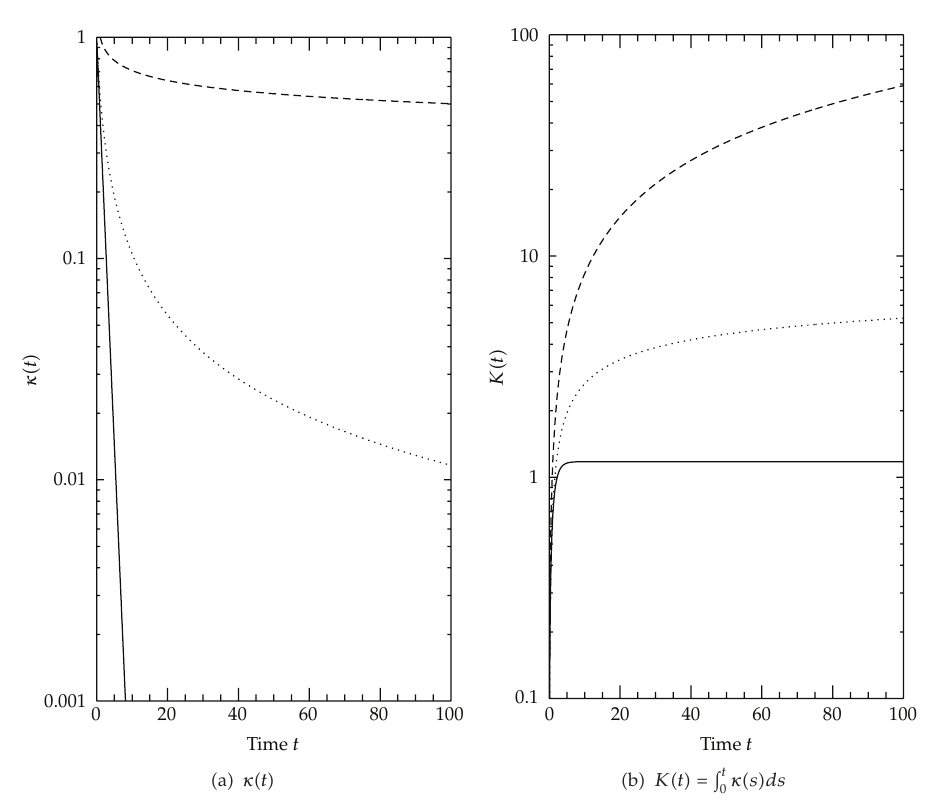
Figure 2: Time dependence of three relaxation functions for κ (cid:3) t (cid:4) in Table 2: (cid:3) i (cid:4) an exponential function (cid:3) solid line (cid:4) , (cid:3) ii (cid:4) an inverse power function (cid:3) dotted line (cid:4) , and (cid:3) iii (cid:4) a fractional power function (cid:3)